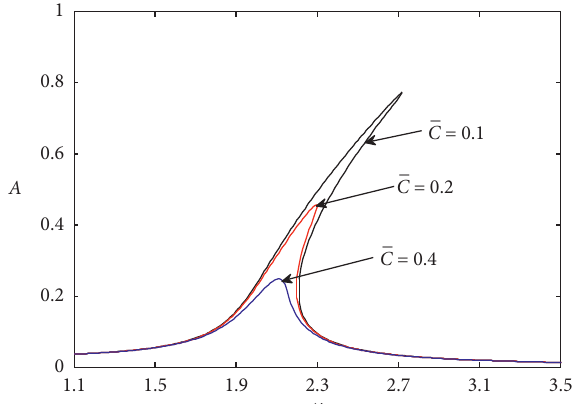
Figure 7: The frequency-response curves of the system for different nondimensional material length scale parameters l / h